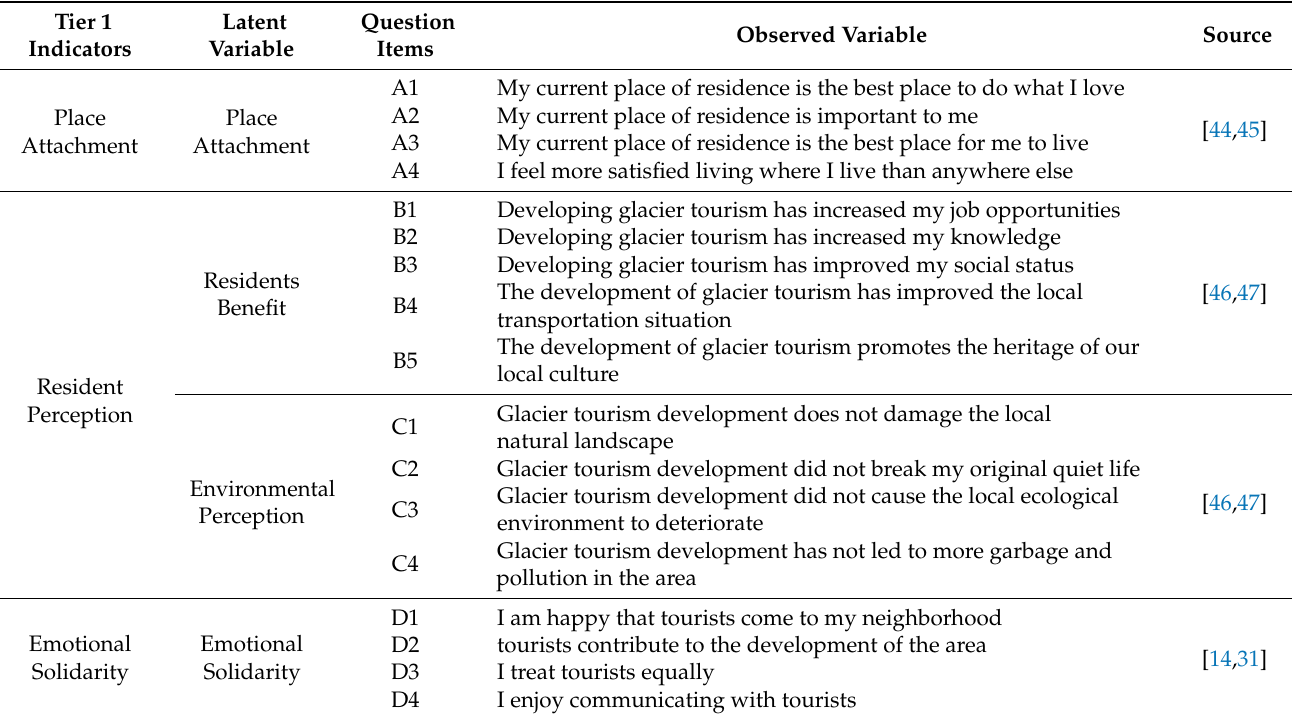
Table A1. Resident Tourism Perception and Attitude Measurement